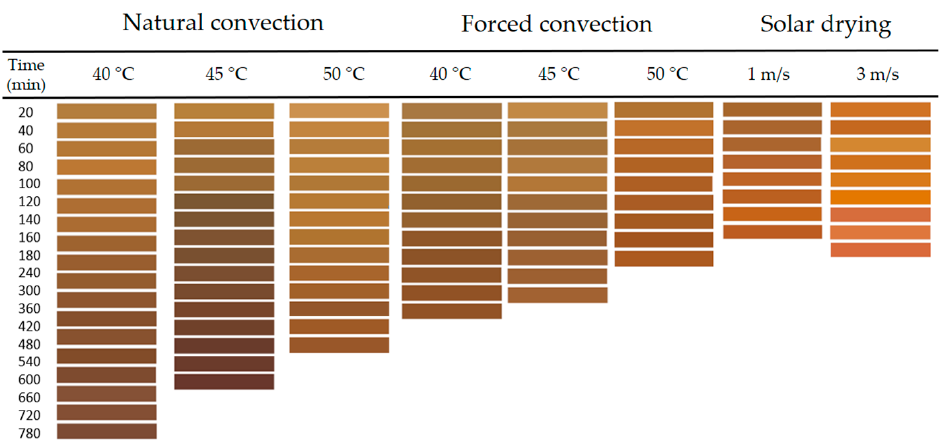
Figure 4. Color change as a function of time for di ff erent drying modes (natural convection, forced convection, and solar drying).